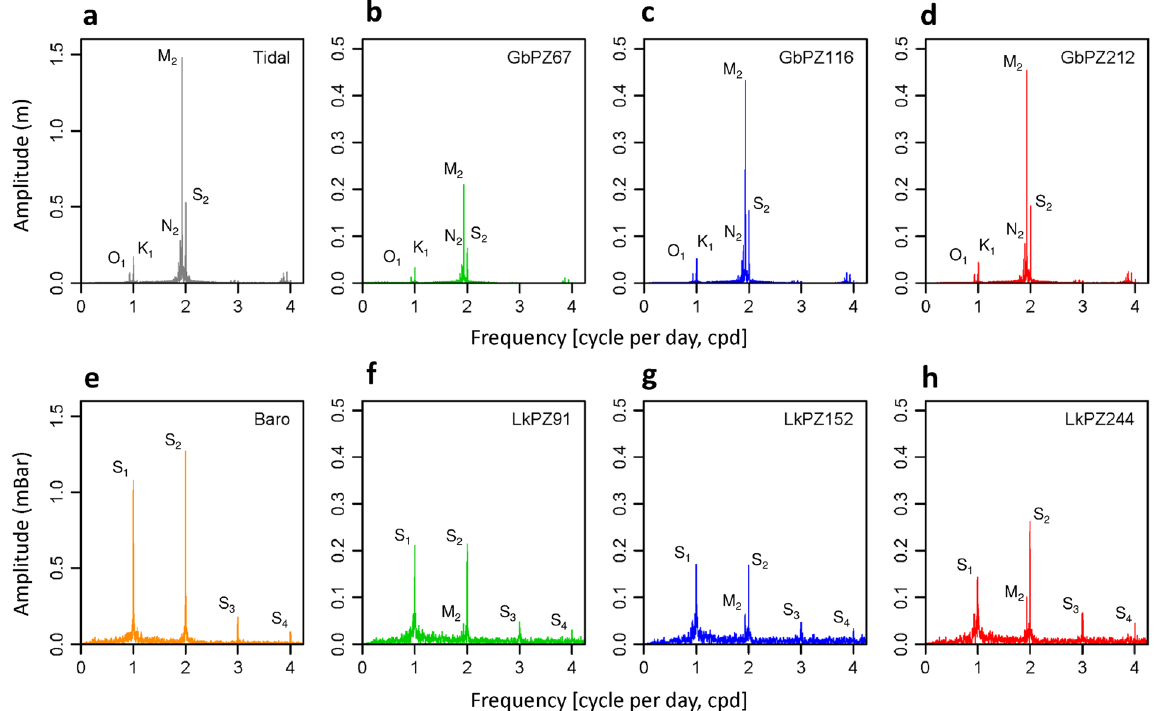
Figure 2. Amplitudes of the tidal and atmospheric signals and groundwater responses at Gabura and Laksmipur. Top: amplitude versus frequency for ( a ) the Chittagong tide and ( b – d ) the groundwater heads at GbPZ67, GbPZ116 and GbPZ212 respectively, 1 st June 2013 to 31 st May 2014, showing the principal solar-lunar tidal components 17 O 1 , K 1 , N 2 , M 2 and S 2 , and additional minor components (see text). Bottom: amplitude versus frequency for ( e ) atmospheric pressure at Laksmipur, and ( f – h ) groundwater pressure measured in piezometers LkPZ91, LkPZ152 and LkPZ244 respectively, over the period of hydrograph recession between 1 November 2013 and 30 April 2014.